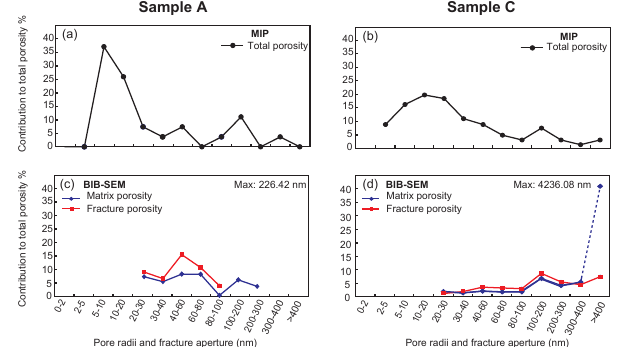
Figure 12. Pore radii and fracture aperture distributions from MIP compared to image analysis of BIB-SEM images. The pore radius is calculated from the pore area and for the fracture aperture, the minor axis of the calculated fit ellipse is used. (a, b) Pore size distributions of MIP results of samples A and C. (c, d) Pore size distributions of BIB-SEM analysed sub-samples divided into matrix and fracture porosity. MIP and BIB-SEM distributions show same general trend with a peak at the 100–200nm pore radii. Dashed line: large pore sizes (>300nm) disturb distributions because of heterogeneity ef-